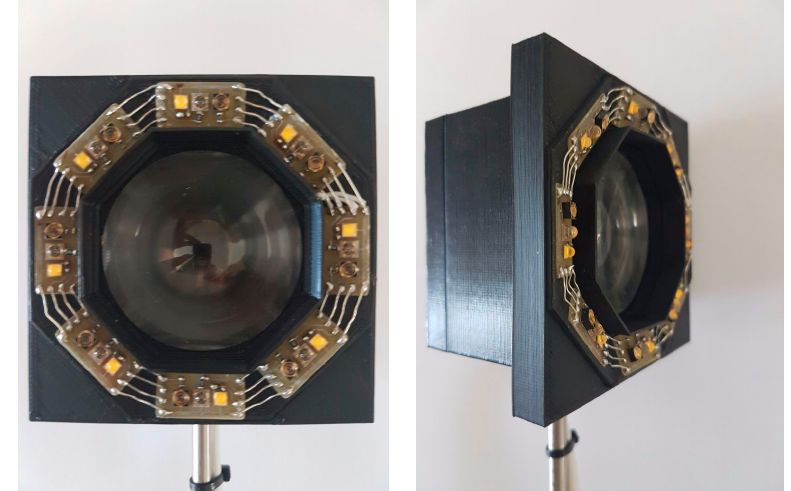
Figure 1. The multispectral sensor: ( left ) The disk in the middle is the Fresnel lens. The three LED’s in each plate emit, in turn, visible light 450–700nm, and infrared at 810 nm and 940 nm. All eight LEDs of each spectral band are lit simultaneously for 20.8 microseconds (i.e., three circular arrays of eight LEDs each). All LEDs’ supporting plates have a 68.5 ◦ orientation with respect to the Fresnel plane ( right ). The photodiode is placed at the focal point of the Fresnel lens.